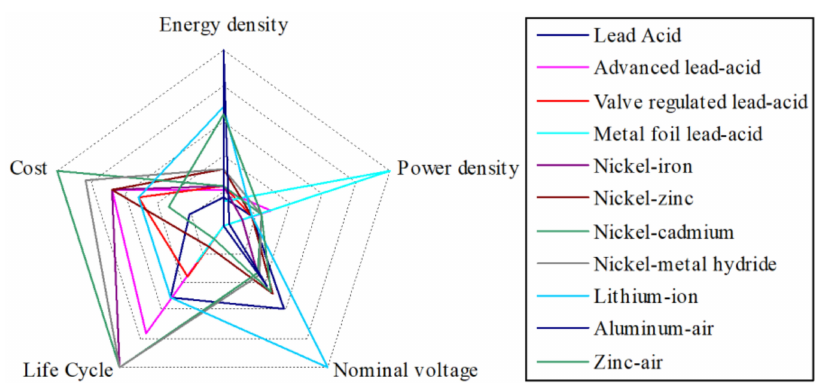
Figure 2. Spider chart for the different battery